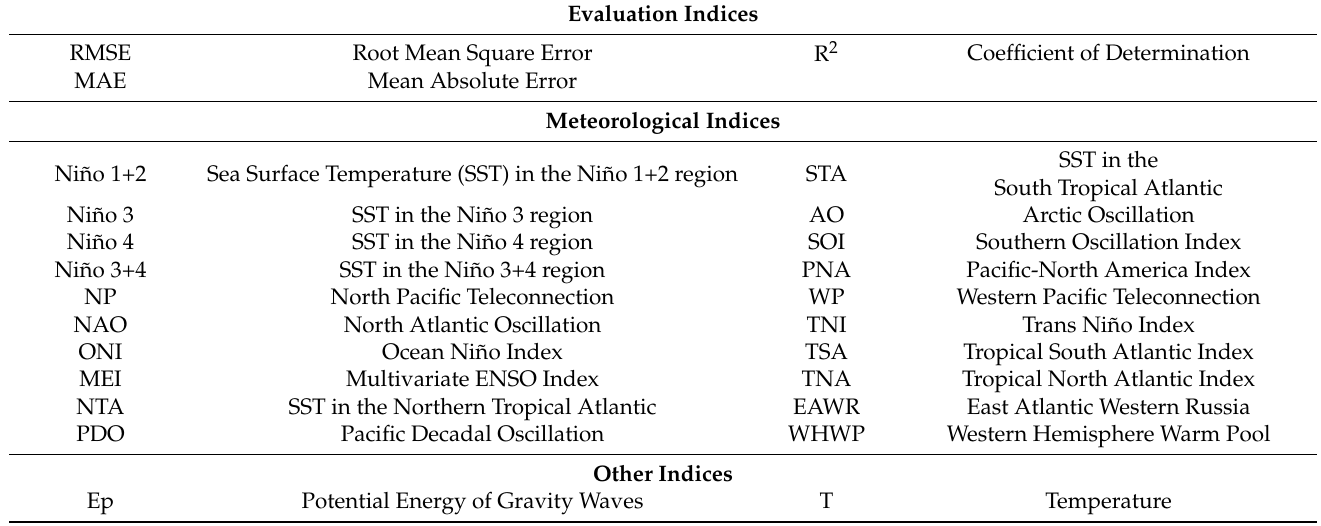
Table 1. Abbreviations and full names of various indices.